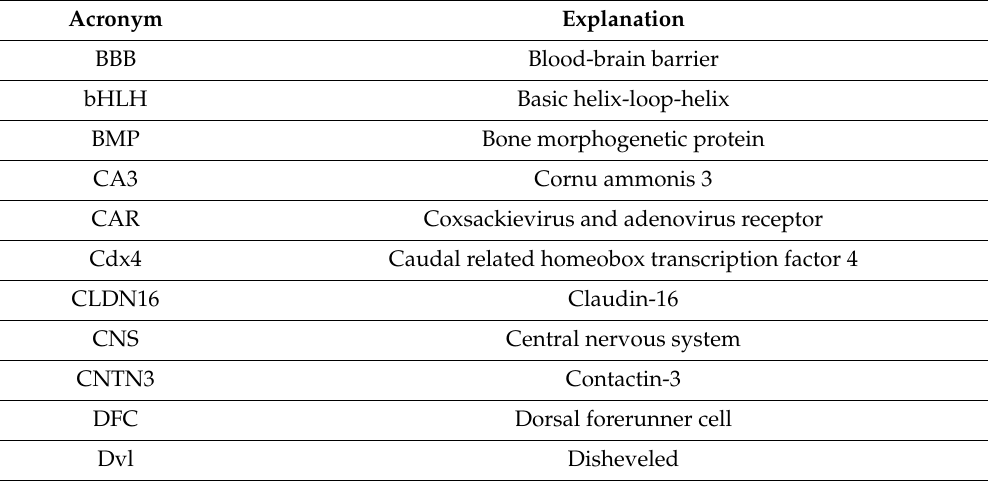
Table 1. An explanation of acronyms in alphabetical